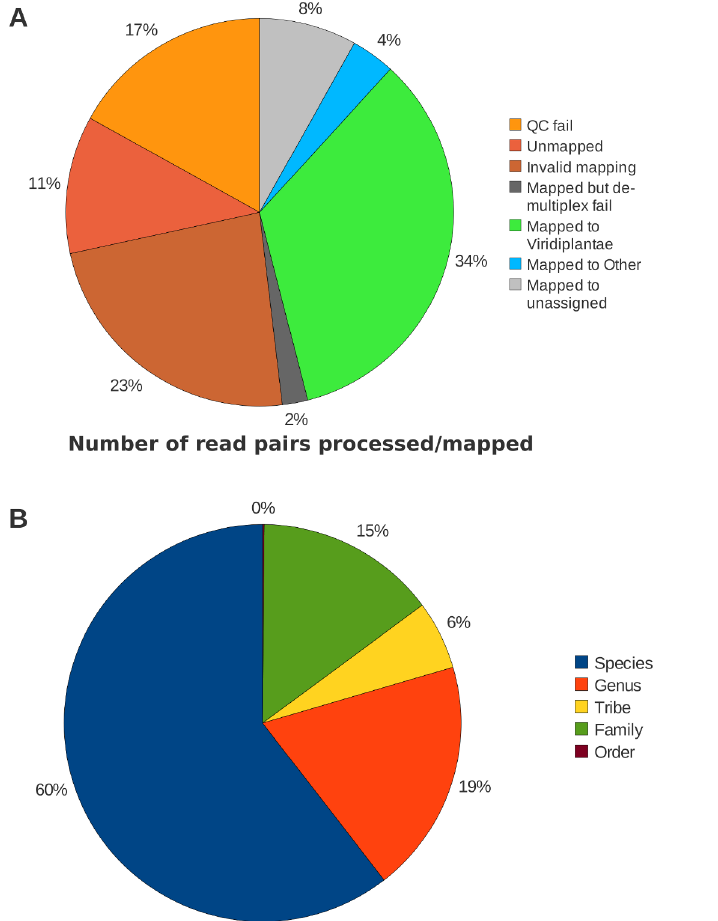
Fig 1. Pie charts summarizing sequencing output and read